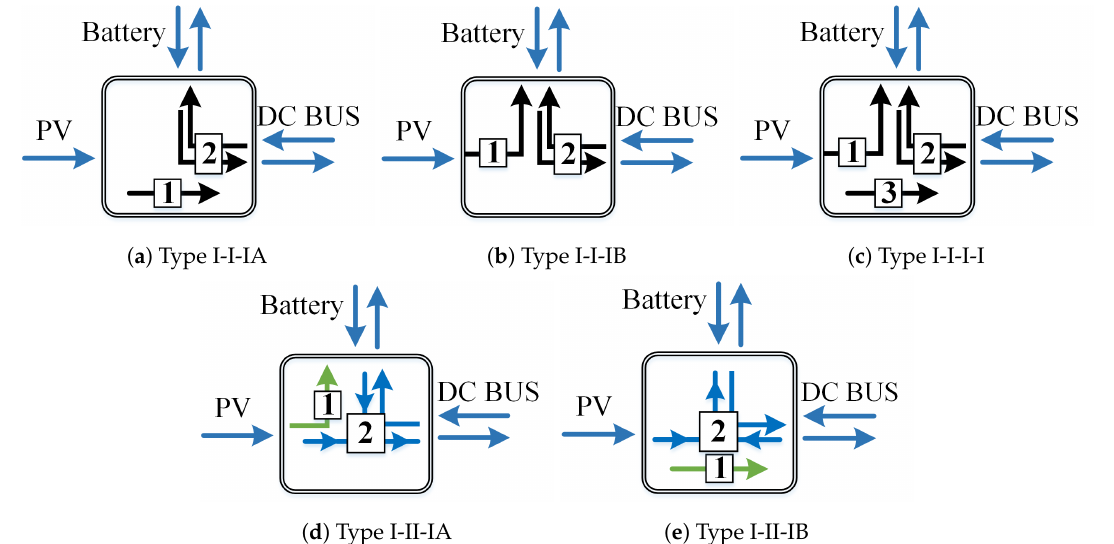
Figure 5. Some possible power flow graphs configurations based on Figure 4.